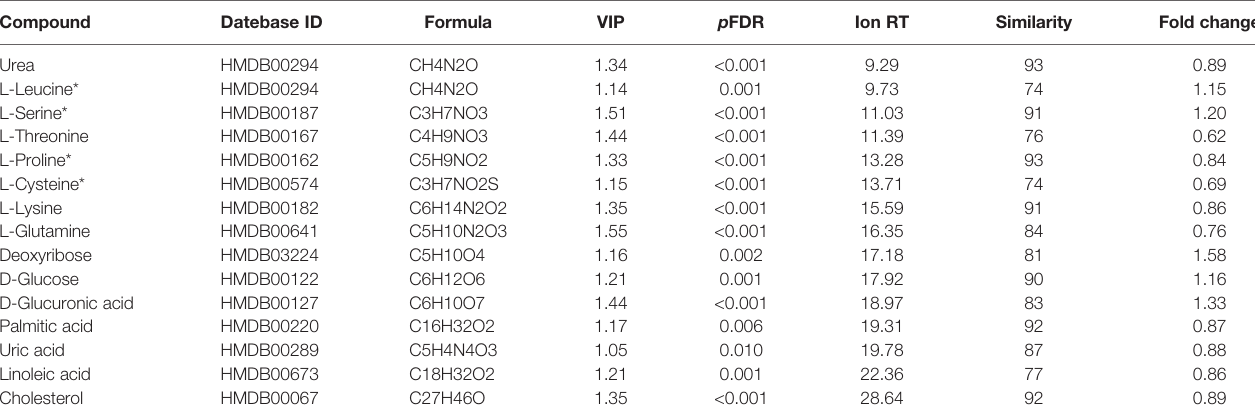
TABLE 2 | Differential metabolites identi fi ed by GC-MS.